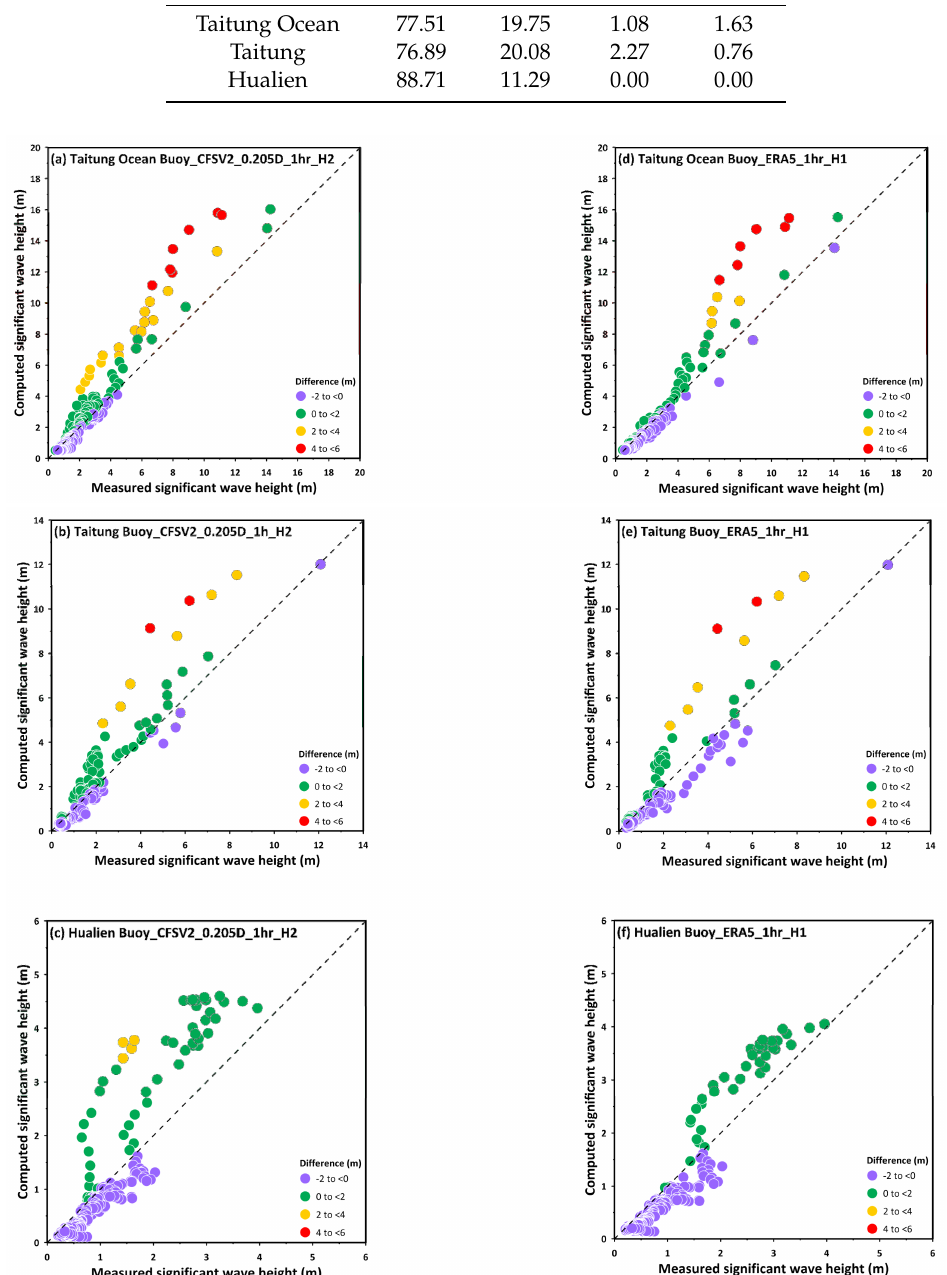
Figure 12. Scatter plot of computed versus measured SWHs at the ( a , d ) Taitung Ocean, ( b , e ) Taitung, and ( c , f ) Hualien buoys employing the winds from CFSV2_0.205D_1hr_H2 ( a – c ) and ERA5_1hr_H1 ( d – f